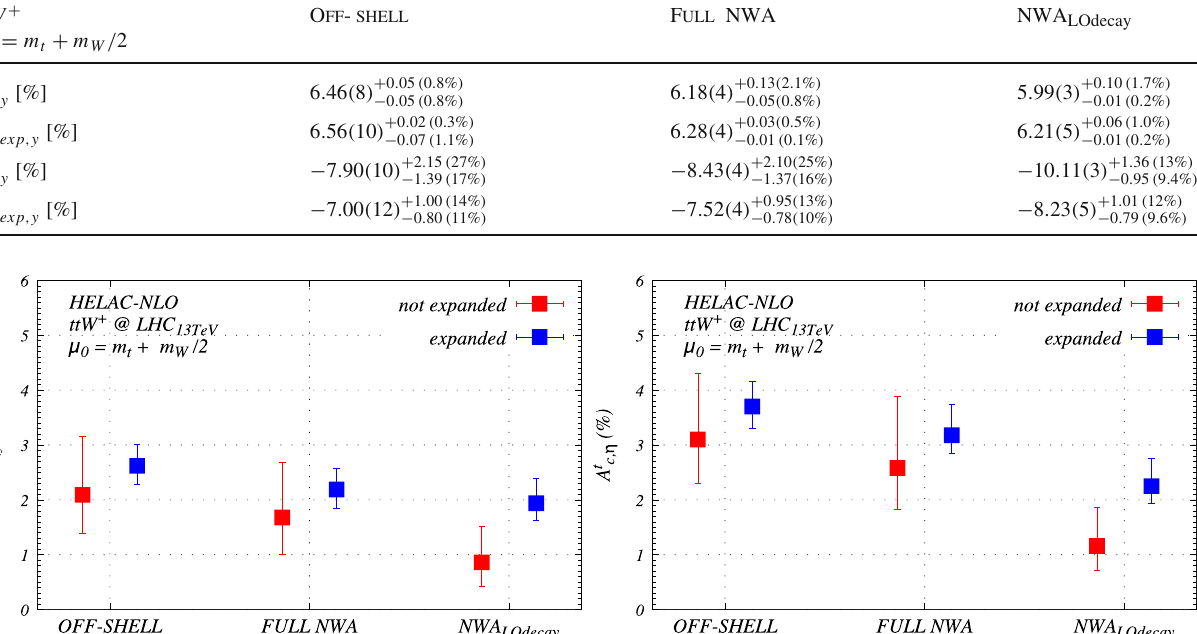
Table 4 Unexpanded and expanded A (cid:4) c and A b c asymmetries at NLO in QCD for pp → t ¯ tW + in multi-lepton channel at the LHC with √ s = 13 TeV. Various approaches for the modelling of the top quark production and decays are considered: the full off-shell case, the full